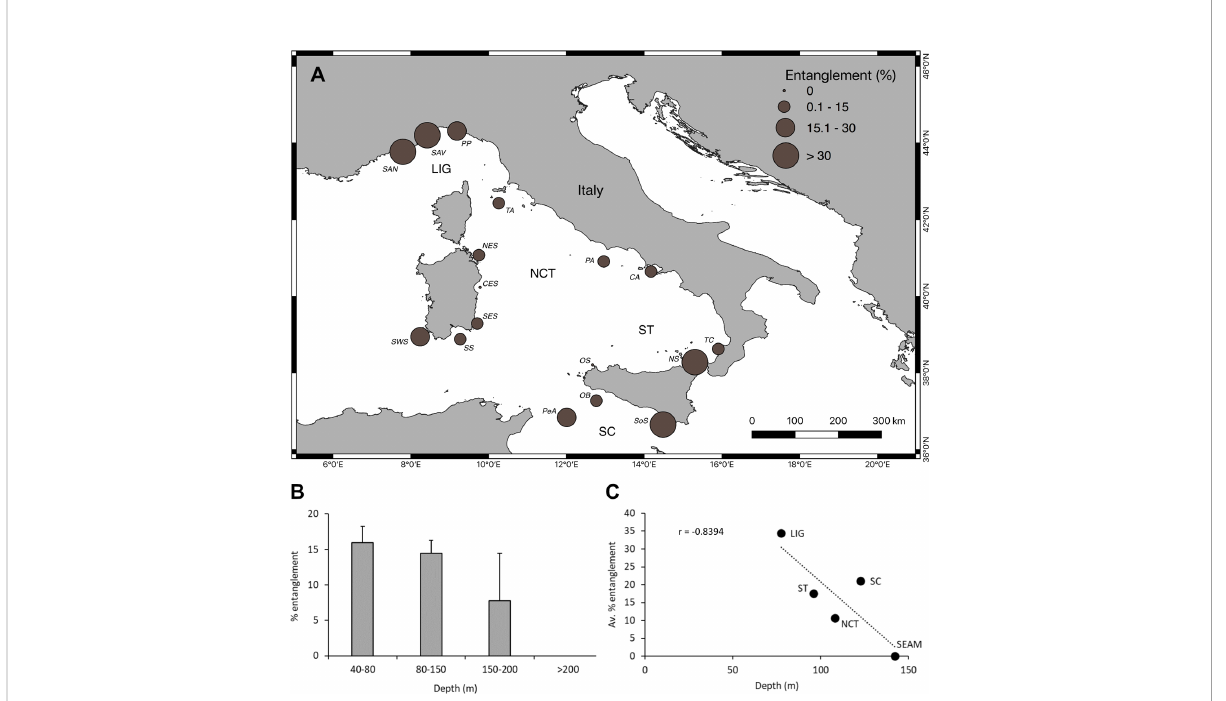
FIGURE 7 Fishing impact. (A) Map of the coral areas showing evident traces of impact (entanglement) by nets and longlines. The size of the dots refers to the average percentage of entanglement. (B) Relationship between the average percentage of entangled colonies and depth in the four depth ranges. (C) Correlation between the average percentage entanglement per macro-area and